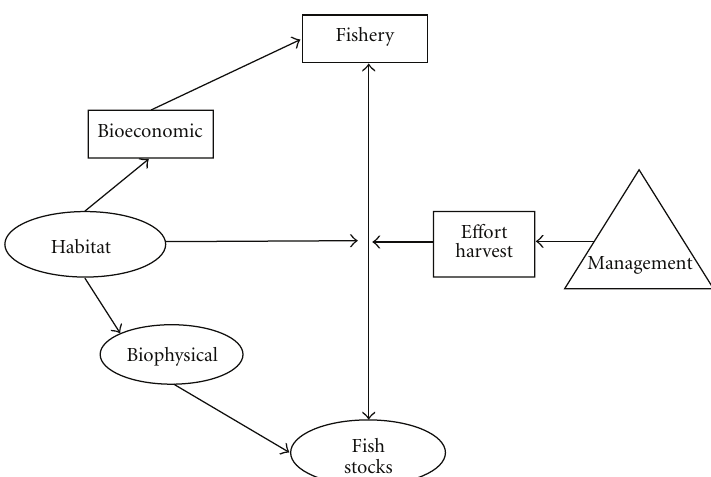
Figure 1: Habitat interactions. Interactions drawn in the ovals represent biological entities associated with habitat, while squares and triangles are human behavioural